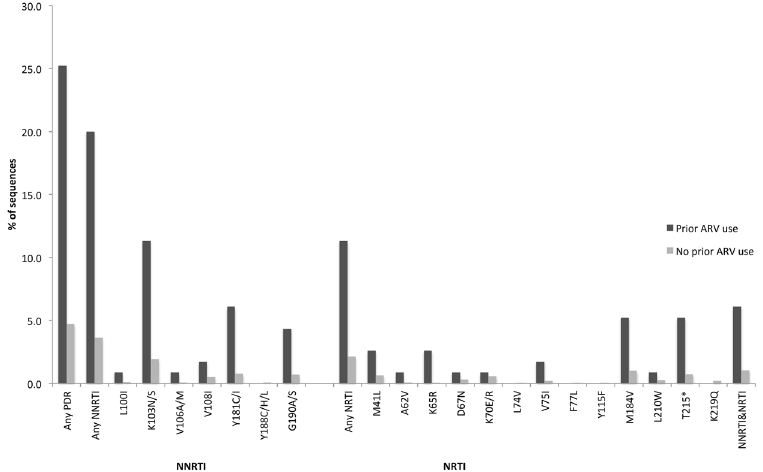
Figure 2. Patterns of drug resistance mutations in participants with and without prior ARV use Of all DRMs detected, 25.2% occurred in the participants with PAU. The proportion of participants who carried NNRTI, NRTI and dual NNRTI + NRTI resistance was 20.0%, 11.3% and 6.1% respectively for those with PAU